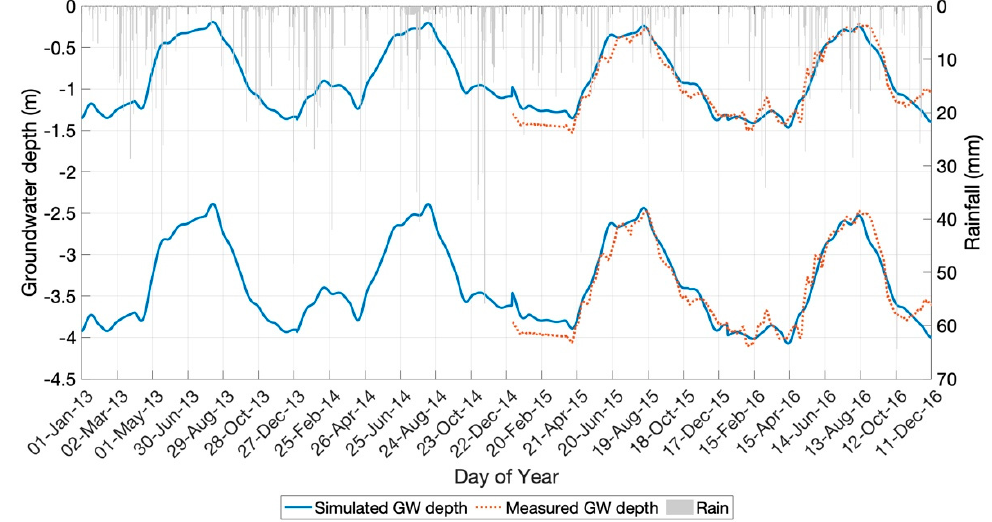
Figure 9. Groundwater table depth series estimated through the application of the ‘feedback flow path’ (solid line); for the years 2015 and 2016 data series obtained after the interpolation and the zonation of groundwater level measures are also reported (dotted line).